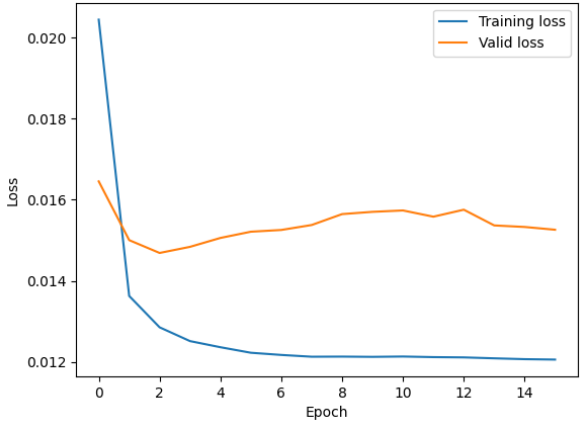
Figure 5. The training and validation loss curves of the BO-LSTM model.